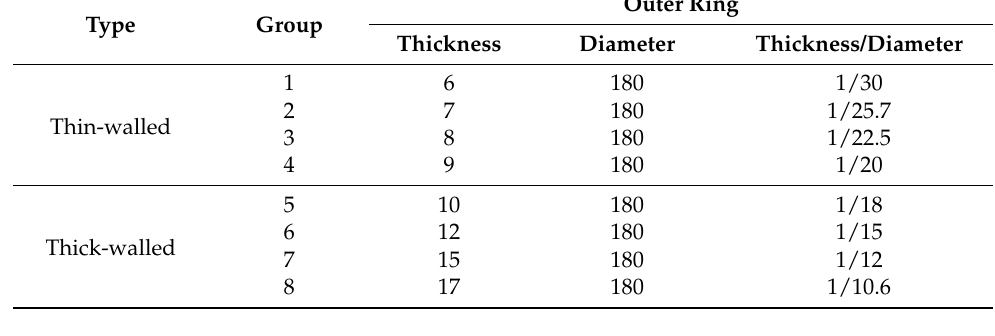
Table 2. Setting of working conditions for changing wall thickness/diameter (unit: mm).